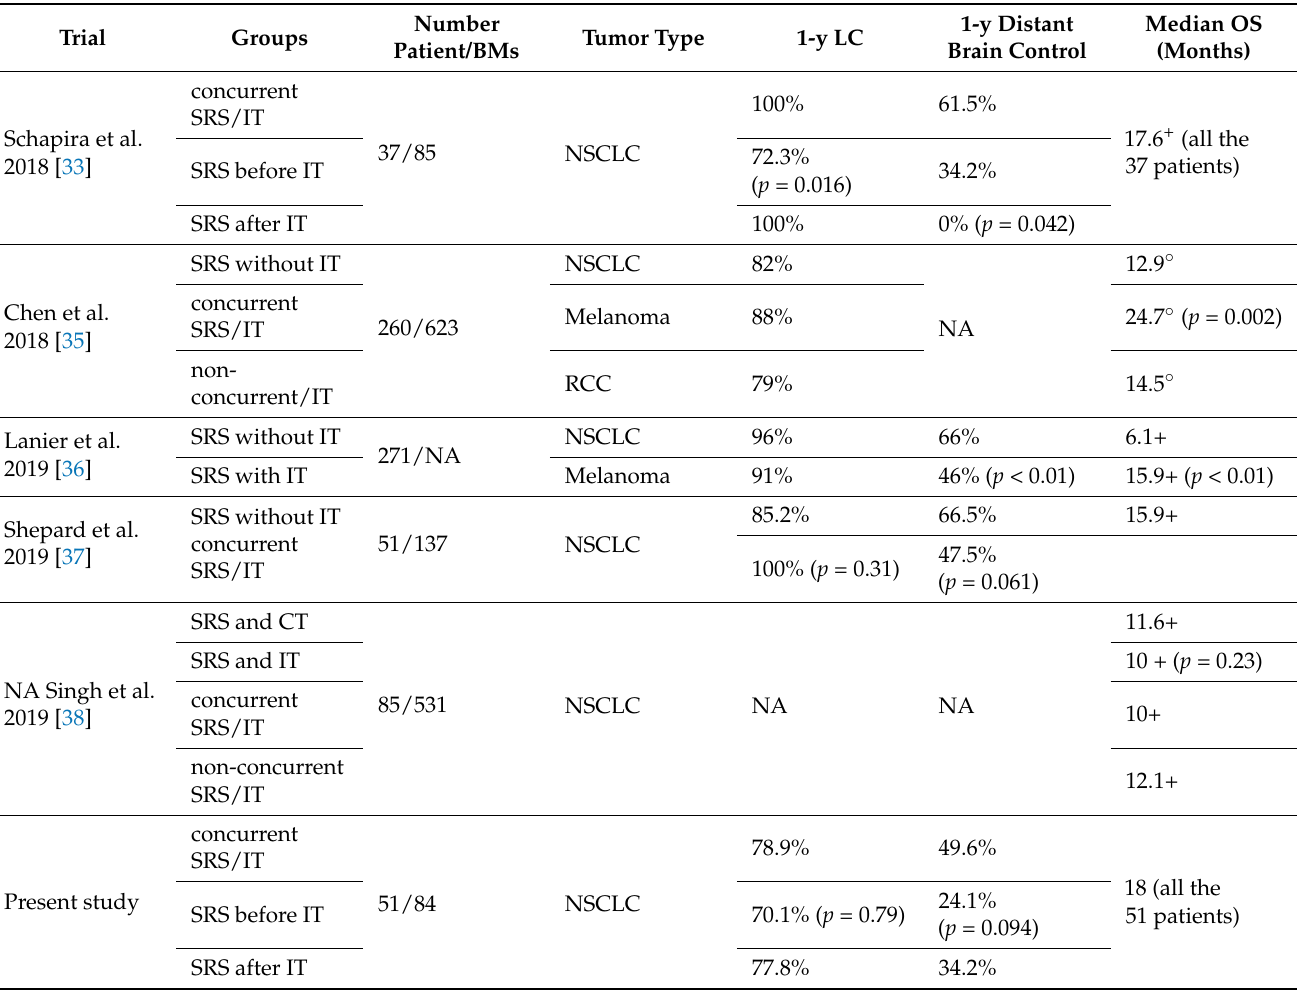
Table 3. Outcomes of the combination of IT and intracranial SRT for patients with brain metastases from lung